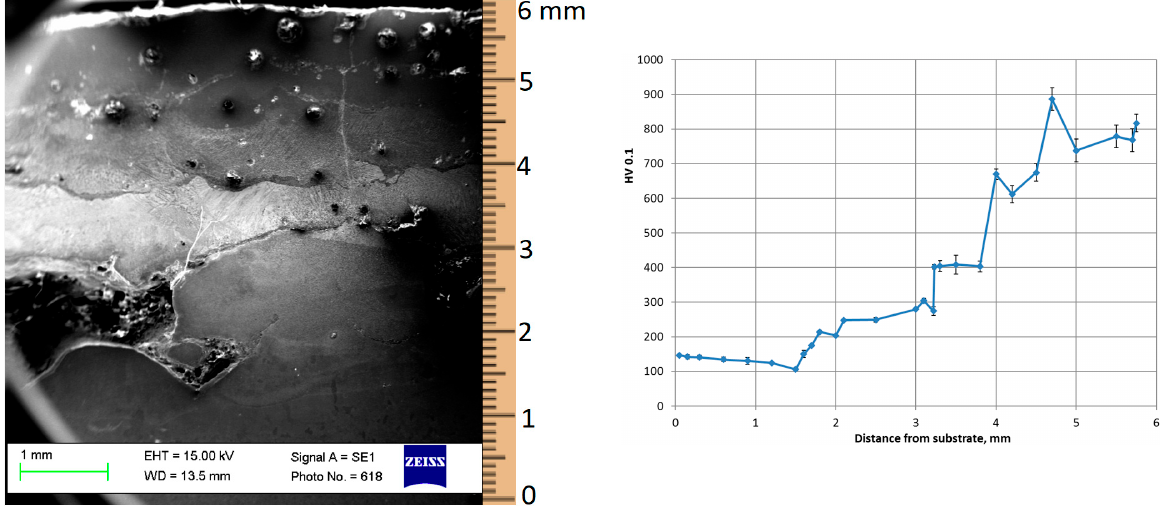
Figure 5. SEM micrograph and microhardness behavior of the DED of a Ti-Fe-graded layered sample produced by the 2nd mode.